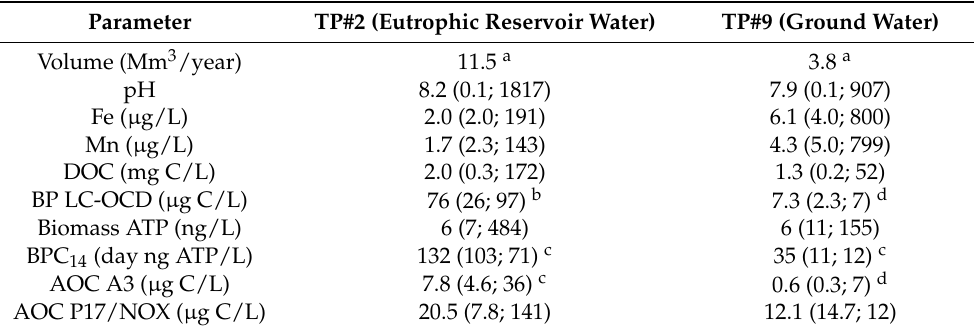
Table 1. Production volume, pH, metals (Fe, Mn), dissolved organic carbon (DOC), biopolymers (BP LC-OCD), biomass (ATP) and biological stability (growth potential parameters) of the drinking water of TP#2 and TP#9 over the period 2012–2021 (mean values, with standard deviation s.d. and number of